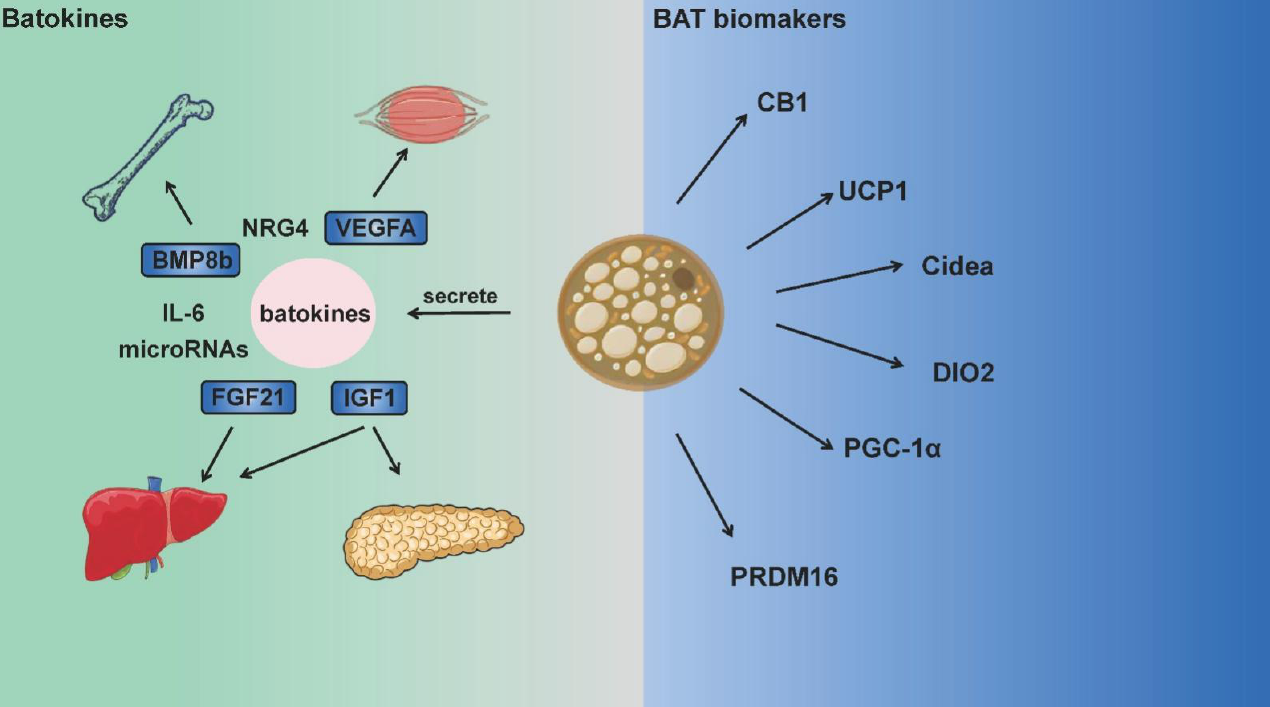
Figure 1. BAT biomarkers and batokines integrating energy metabolism between multiple organs. Brown adipose tissue is rich in mitochondria, and expresses UCP1, CB1, DIO2 and other thermogenic proteins as biomarkers. Moreover, batokines (such as FGF21, BMP8, IL-6) secreted by BAT act on multiple organs including the muscle, bone, brain, liver and pancreas. These batokines participate in numerous physiological activities as “crosstalk molecules” and integrate adipose tissue thermogenesis with the total energy metabolism.